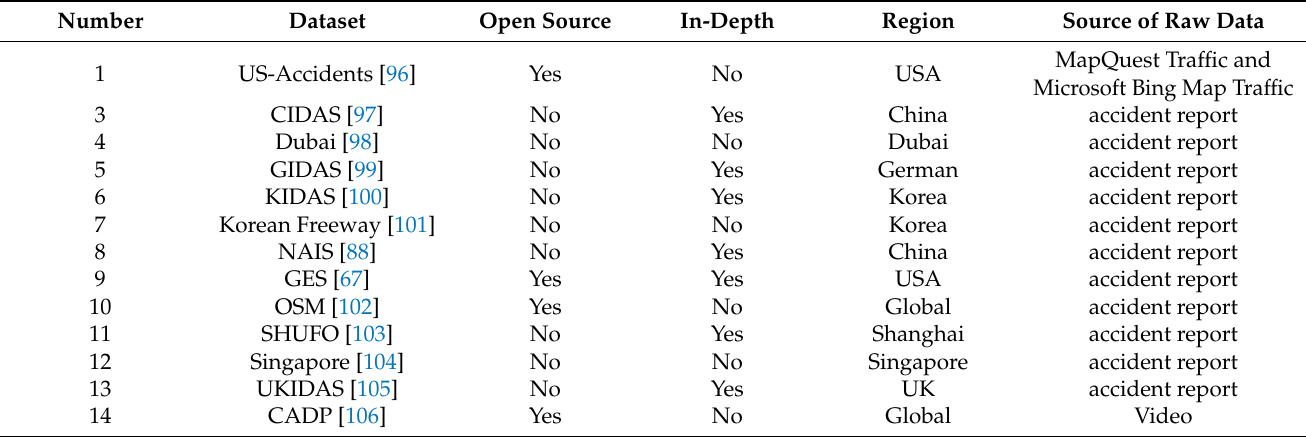
Table 2. 14 Accident datasets. “In-Depth” indicates an in-depth accident